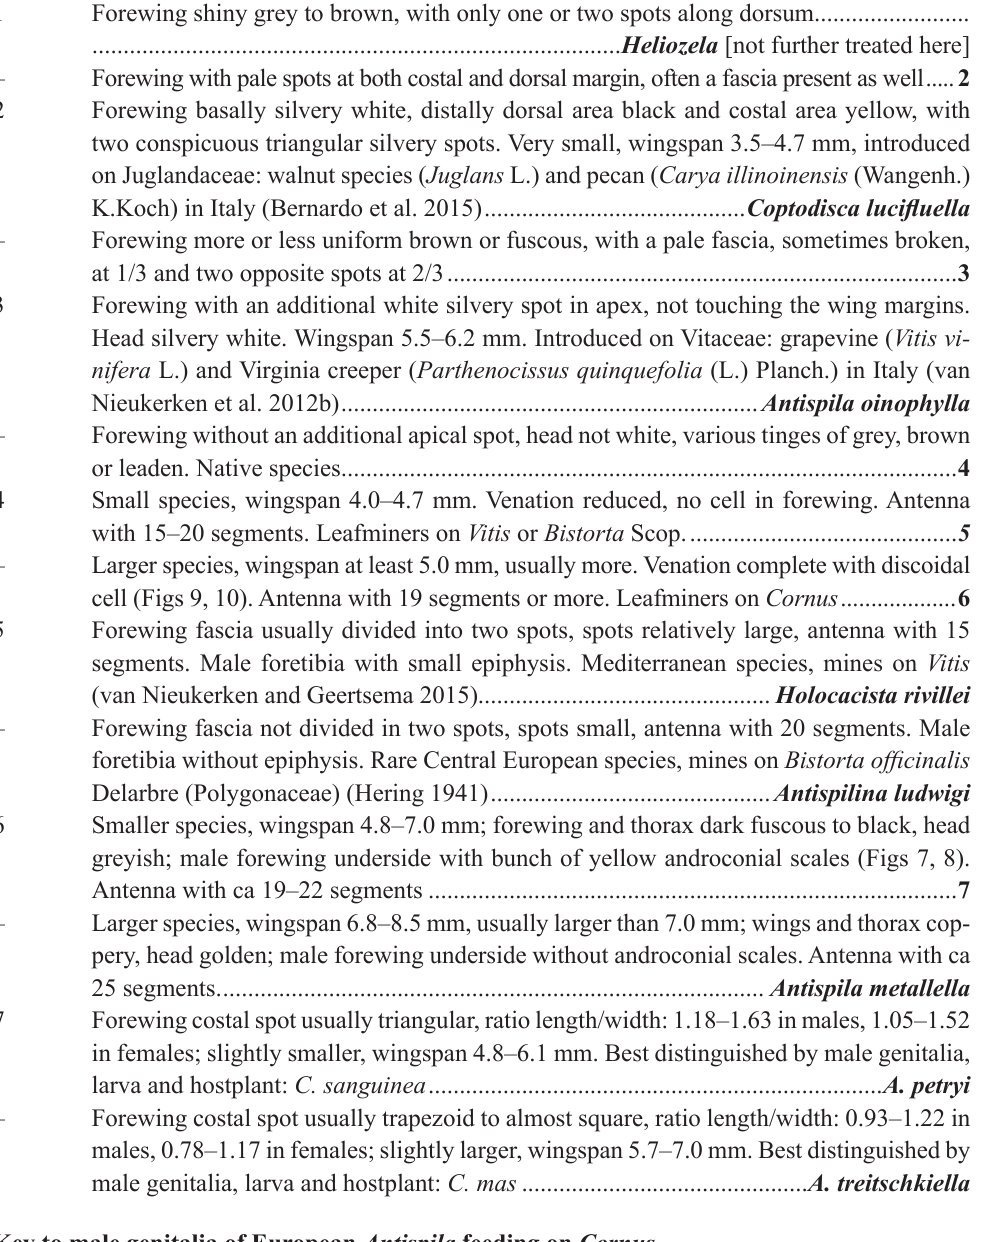
Forewing shiny grey to brown, with only one or two spots along dorsum......................... – Forewing with pale spots at both costal and dorsal margin, often a fascia present as well ..... 2 2 Forewing basally silvery white, distally dorsal area black and costal area yellow, with two conspicuous triangular silvery spots. Very small, wingspan 3.5–4.7 mm, introduced on Juglandaceae: walnut species ( Juglans L.) and pecan ( Carya illinoinensis (Wangenh.) K.Koch) in Italy (Bernardo et al. 2015) .......................................... Coptodisca lucifluella – Forewing more or less uniform brown or fuscous, with a pale fascia, sometimes broken, at 1/3 and two opposite spots at 2/3 .................................................................................. 3 3 Forewing with an additional white silvery spot in apex, not touching the wing margins. Head silvery white. Wingspan 5.5–6.2 mm. Introduced on Vitaceae: grapevine ( Vitis vi- nifera L.) and Virginia creeper ( Parthenocissus quinquefolia (L.) Planch.) in Italy (van Nieukerken et al. 2012b) ................................................................... Antispila oinophylla – Forewing without an additional apical spot, head not white, various tinges of grey, brown or leaden. Native species ................................................................................................... 4 4 Small species, wingspan 4.0–4.7 mm. Venation reduced, no cell in forewing. Antenna with 15–20 segments. Leafminers on Vitis or Bistorta Scop. ........................................... 5 – Larger species, wingspan at least 5.0 mm, usually more. Venation complete with discoidal cell (Figs 9, 10). Antenna with 19 segments or more. Leafminers on Cornus ................... 6 5 Forewing fascia usually divided into two spots, spots relatively large, antenna with 15 segments. Male foretibia with small epiphysis. Mediterranean species, mines on Vitis (van Nieukerken and Geertsema 2015)............................................... Holocacista rivillei – Forewing fascia not divided in two spots, spots small, antenna with 20 segments. Male foretibia without epiphysis. Rare Central European species, mines on Bistorta officinalis Delarbre (Polygonaceae) (Hering 1941) ............................................. Antispilina ludwigi 6 Smaller species, wingspan 4.8–7.0 mm; forewing and thorax dark fuscous to black, head greyish; male forewing underside with bunch of yellow androconial scales (Figs 7, 8). Antenna with ca 19–22 segments ..................................................................................... 7 – Larger species, wingspan 6.8–8.5 mm, usually larger than 7.0 mm; wings and thorax cop - pery, head golden; male forewing underside without androconial scales. Antenna with ca 25 segments. ....................................................................................... Antispila metallella Forewing costal spot usually triangular, ratio length/width: 1.18–1.63 in males, 1.05–1.52 in females; slightly smaller, wingspan 4.8–6.1 mm. Best distinguished by male genitalia, larva and hostplant: C. sanguinea ......................................................................... A. petryi – Forewing costal spot usually trapezoid to almost square, ratio length/width: 0.93–1.22 in males, 0.78–1.17 in females; slightly larger, wingspan 5.7–7.0 mm. Best distinguished by male genitalia, larva and hostplant: C. mas .............................................. A. treitschkiella Key to male genitalia of European Antispila feeding on Cornus 1 Uncus medially blunt, central lobe reduced or absent. Valva at inner margin with spine - like process (Figs 57, 59) ............................................................................... A. metallella – Uncus with prominent central lobe. Valva without spinelike process ..............................